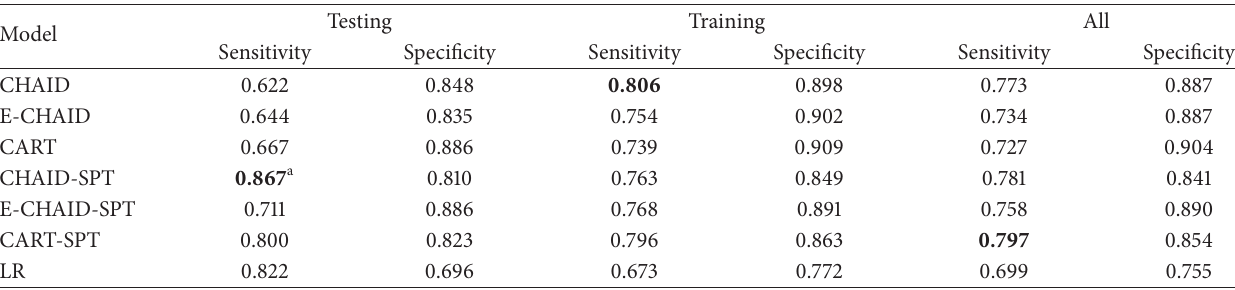
Table 5: Sensitivity and specificity of the DT and LR